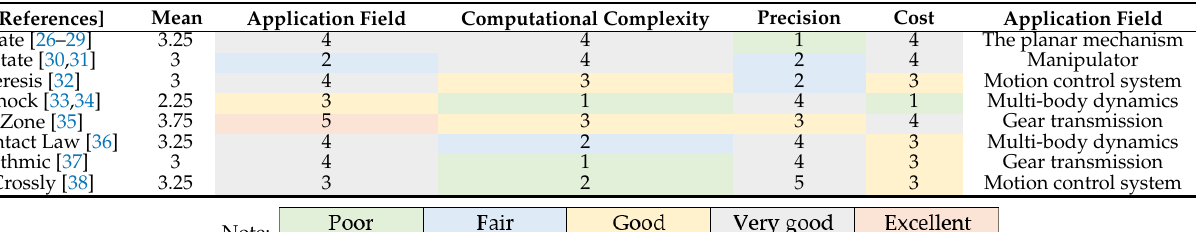
Table 1. Performance analysis of clearance